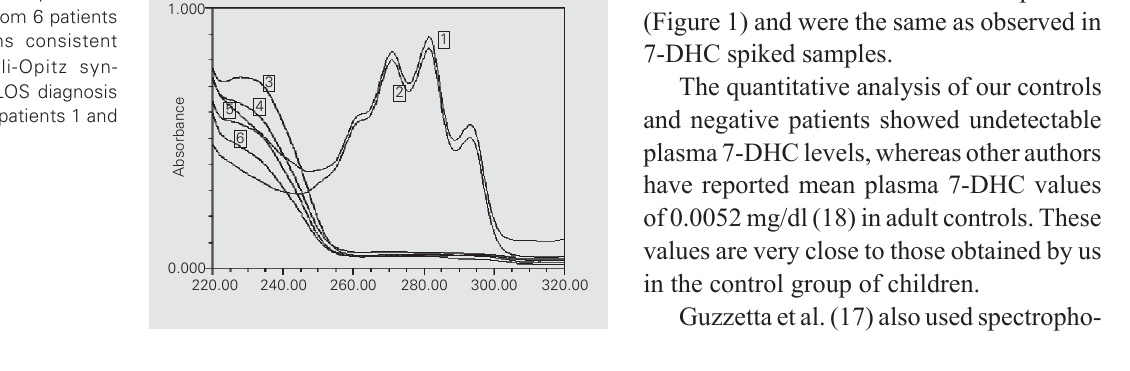
Table 2. Cholesterol and 7-dehydrocholesterol (7-DHC) plasma concentration in 6 suspected Smith-Lemli- Opitz syndrome patients and 23 negative controls.